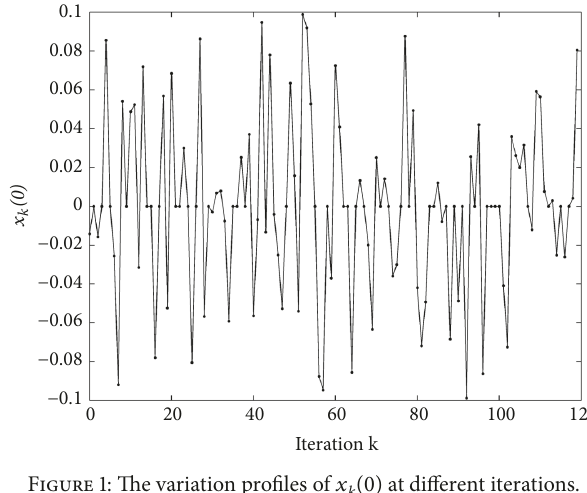
Figure 1: The variation profiles of 𝑥 𝑘 (0) at different